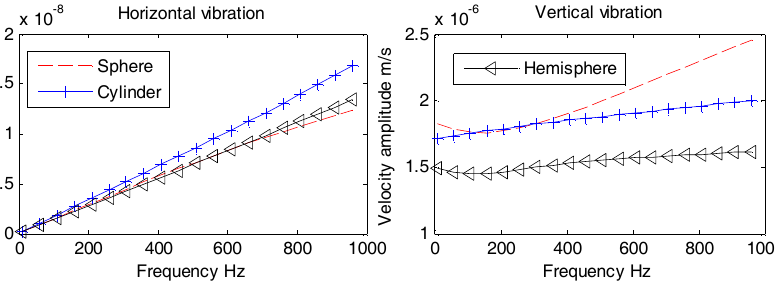
Figure 19. Vibration velocity amplitudes of the OBSs with different shapes under incident angle of 90°.